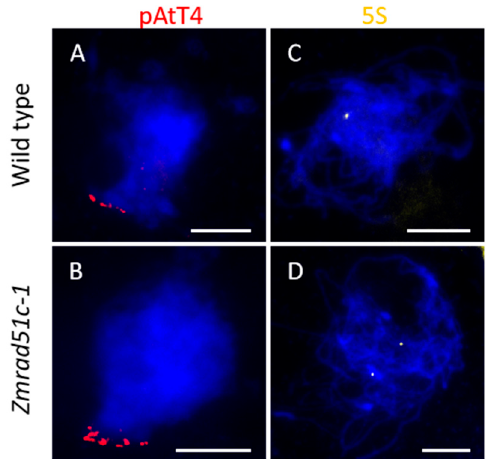
Figure 4. ZmRAD51C is not required for telomere bouquet clustering, but essential for homologous pairing. ( A,B ) FISH detection of telomere bouquet formation using pAtT4 probe in wild type ( A ) and Zmrad51c-1 ( B ). DAPI staining was used to indicate the chromosomes. ( C,D ) FISH detection of homologous pairing using 5S rDNA probe in wild type ( C ) and Zmrad51c-1 ( D ). Scale bars = 10 µm.